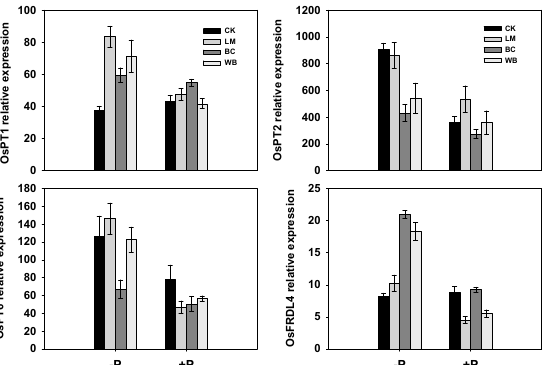
Figure 3. Effect of biochar and P supply on the expression levels of phosphate transporter gene ( OsPT1 , OsPT2 , OsPT6 ) and OsFRDL4 in the rice roots. Each value is the mean ± standard error of four replicates. The treatments were: CK: the control treatment; LM: lime equivalent to a biochar application rate of 20 g kg − 1 ; BC: biochar at an application rate of 20 g kg − 1 ; WBC: washed biochar at an application rate of 20 g kg − 1 .